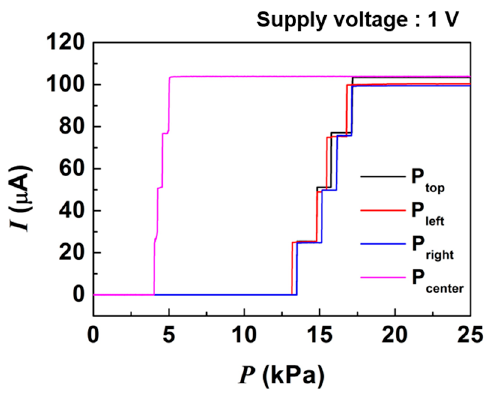
Figure 4. The pressure-dependent output characteristics of pressure sensor units.